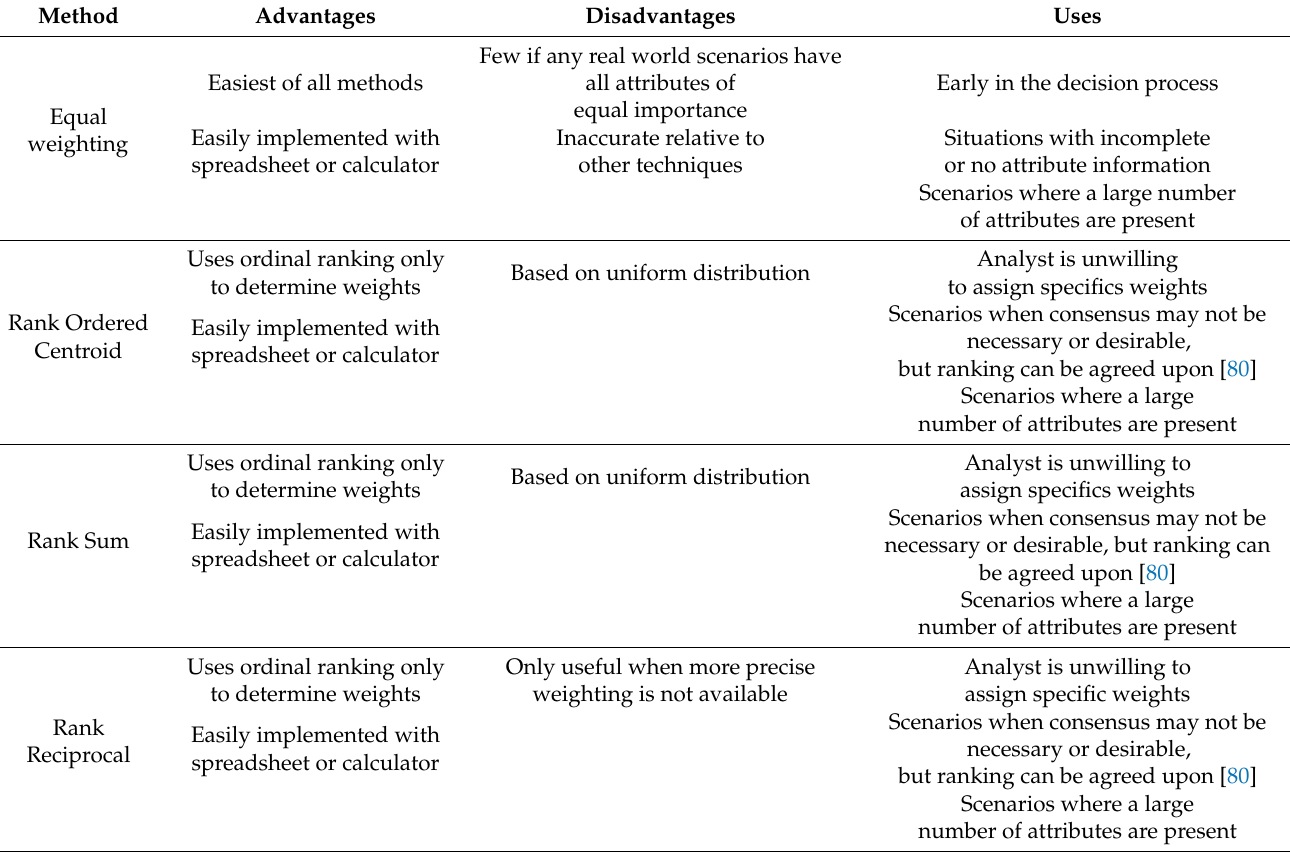
Table 17. Characteristics of weighting methods for approximate